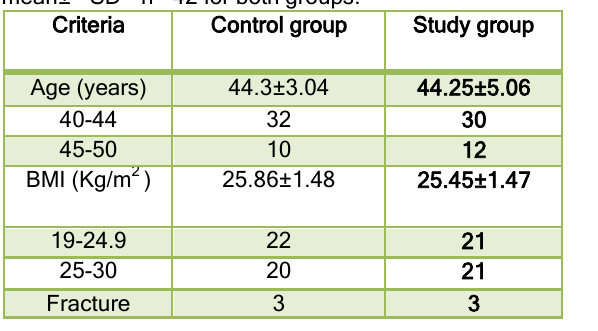
Table 1: The demographic data of the participants. Data was expressed as " mean±srSD" n= 42 for both groups.